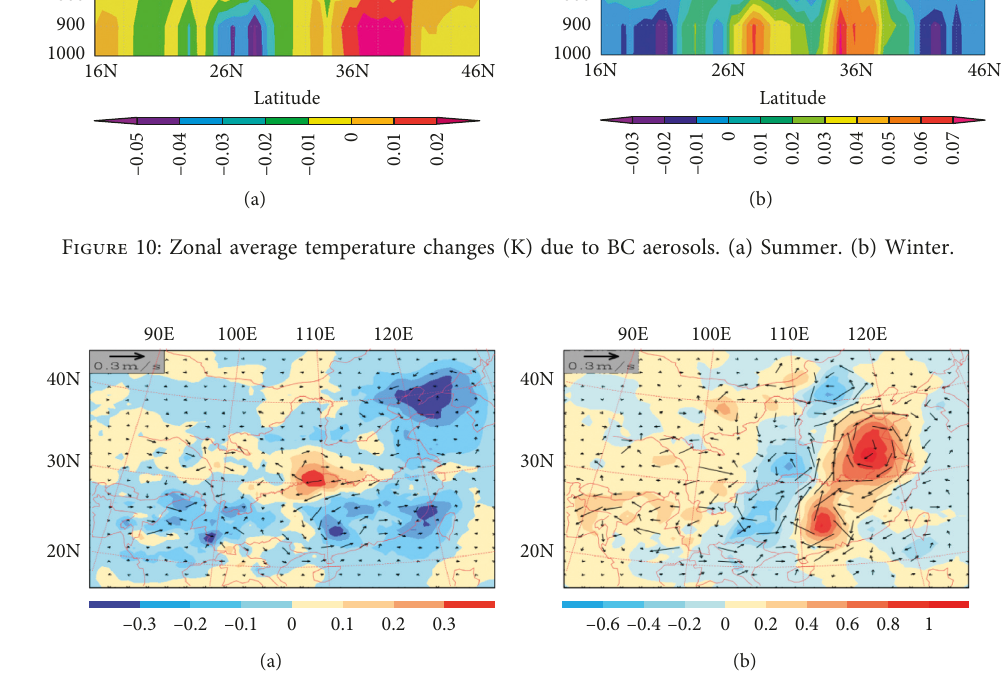
Figure 11: Changes of the average height field and wind field (m/s) at 850hPa. (a) Summer. (b)